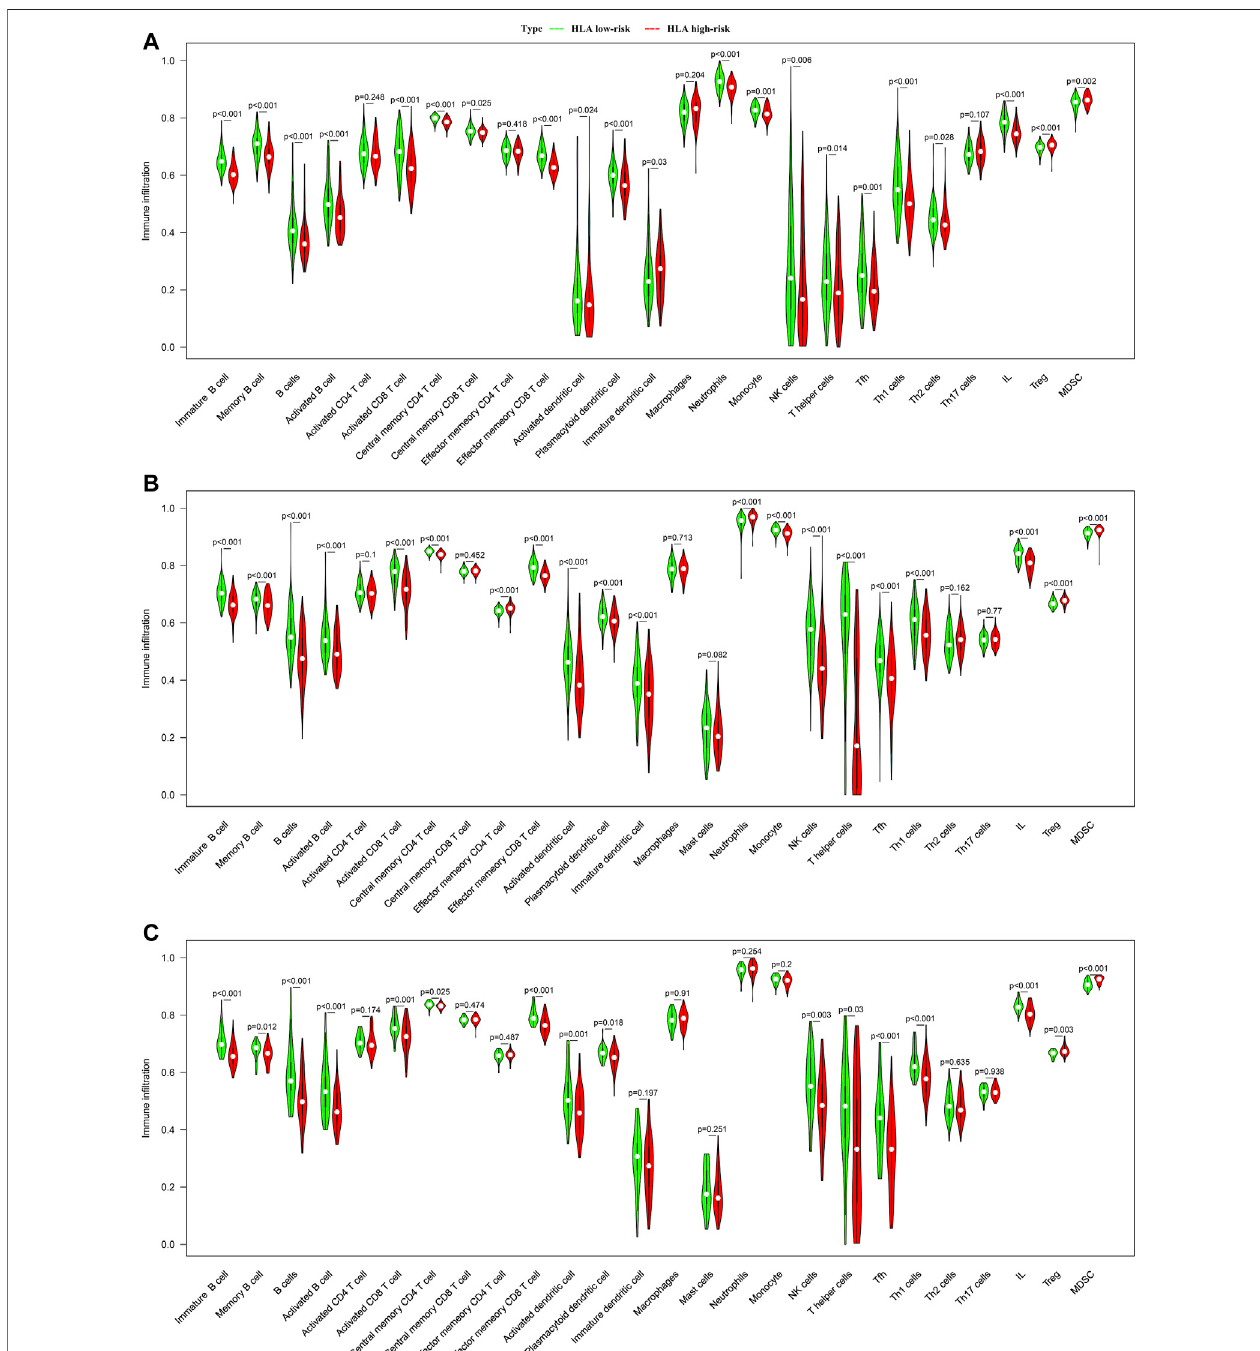
FIGURE 7 | Comparison of in fi ltrating immune cells between different HLA subgroups based on ssGSEA in multiple transcriptome datasets. (A) GSE65682 datasets. (B) E-MTAB-4421 datasets. (C) E-MTAB-4451 datasets. Green indicates HLA low-risk, while red indicates HLA high-risk.